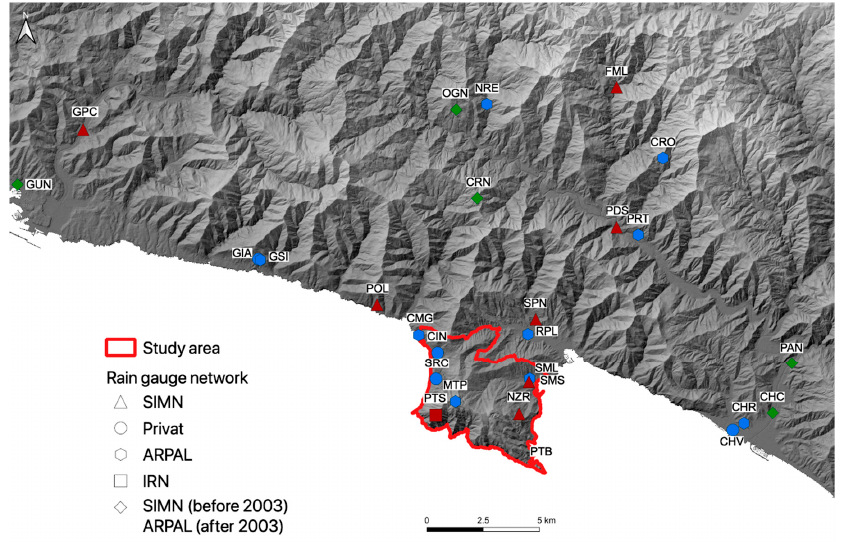
Figure 4. Rain gauges available in the Portofino promontory and surrounding area classified by networks and type of rainfall data. Colored symbols represent different types of rainfall data: red, daily; blue, hourly; green, daily (before 2003) and hourly (after 2003). For rain gauge list, see Table 2. Table 2. Rain gauges used to define rainfall conditions that triggered shallow landslides and debris flows in the Portofino promontory. Type of rainfall data: H, hourly; D, daily. ARPAL = Regional